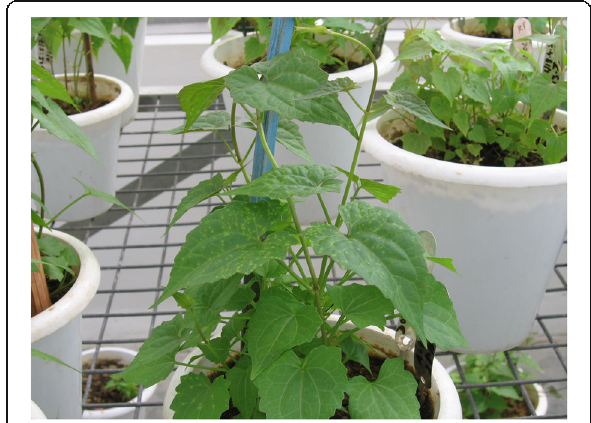
Fig. 2 A representative Mikania micrantha plant from Andaman and Nicobar islands showing early symptoms of infection with the Peruvian pathotype of Puccinia